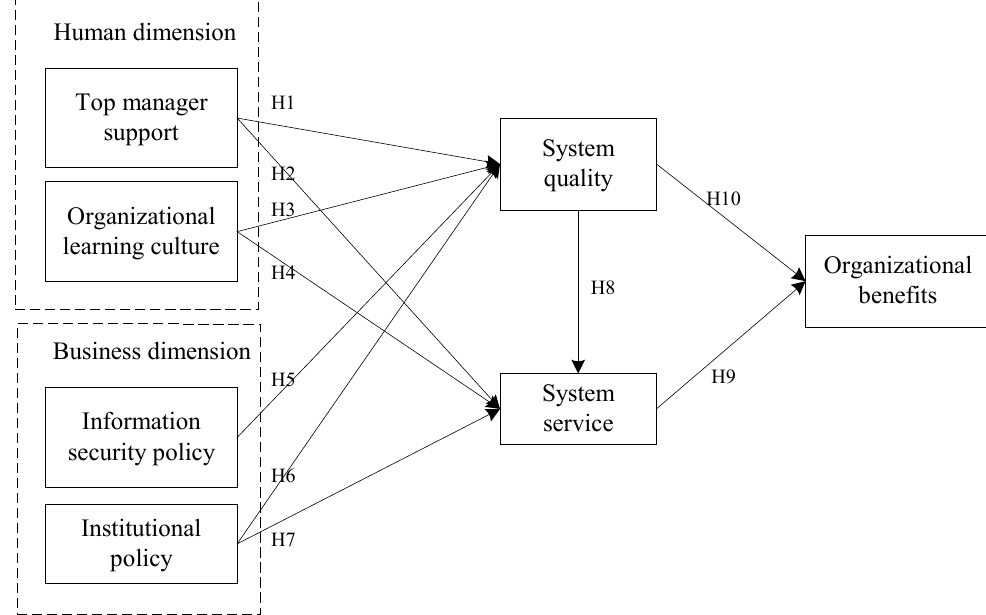
Figure 1. The framework of this study. Top Management Support